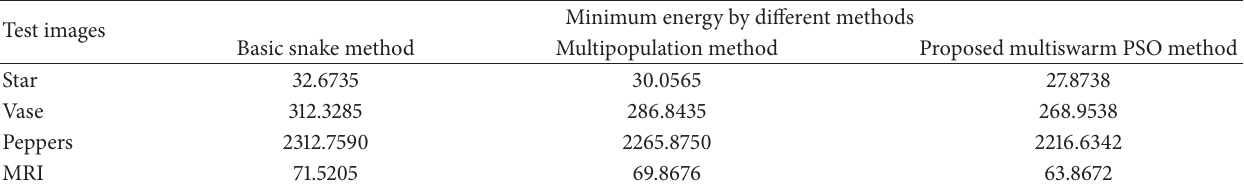
Table 1: Minimum snake energy values obtained by different methods.